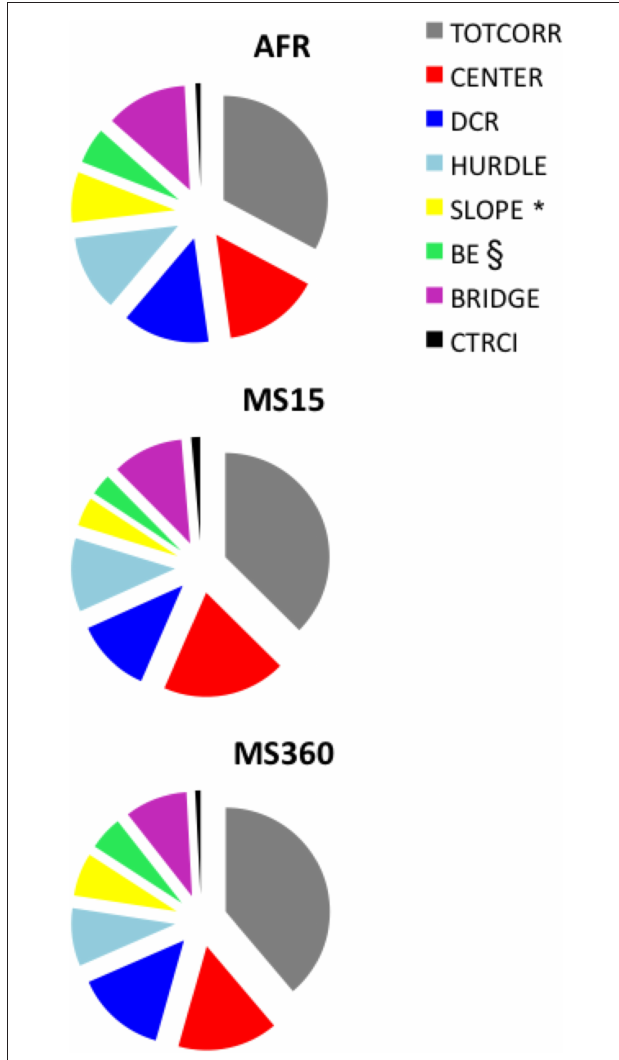
Figure 2 | The percentage of time spent in the defined zones of the MCSF test in AFr, MS15, and MS360 dams ( n = 6/group). § p < 0.10, * p < 0.05 (Kruskal–Wallis test); MS15 dams spent significantly less amount of time on the SLOPE ( Z = 2.88; p < 0.01) and BRIDGE ENTRANCE ( Z = 2.08; p < 0.05) than AFR dams (Mann–Whitney U